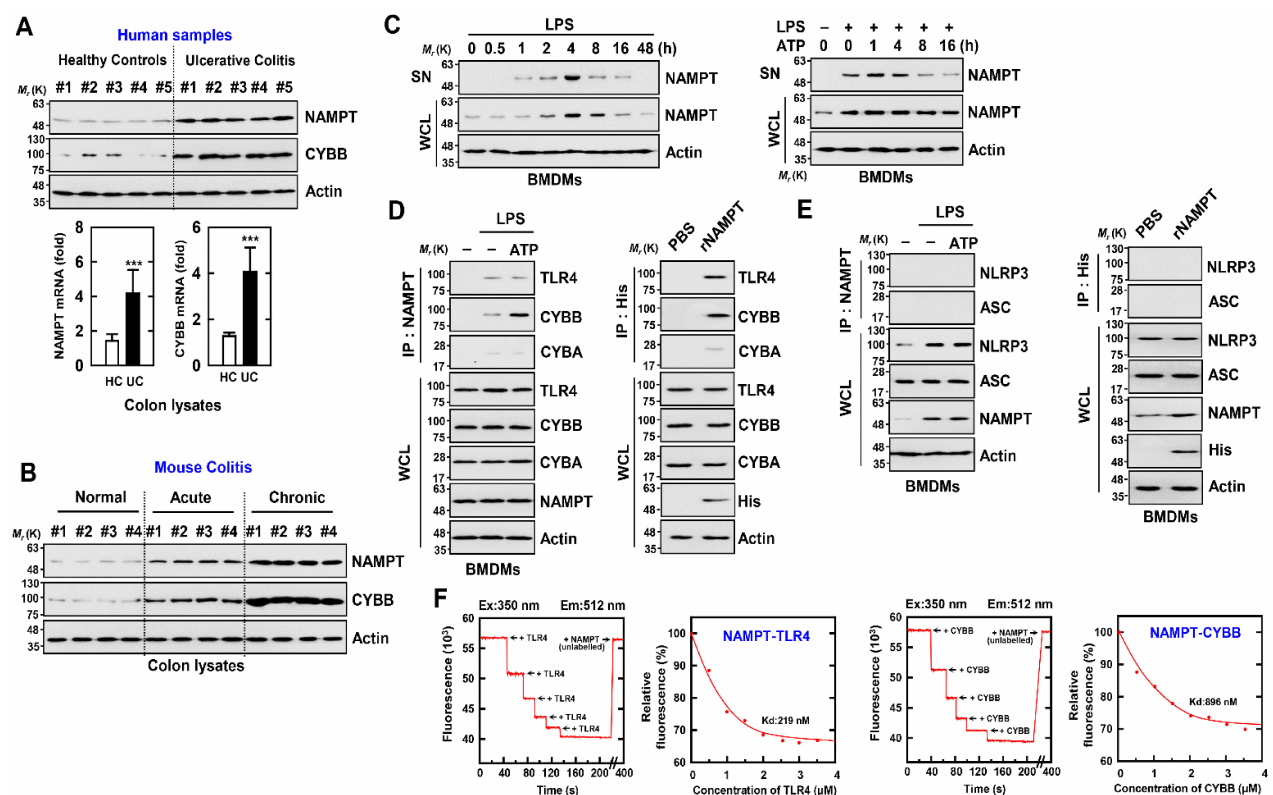
Figure 2. eNAMPT directly binds with CYBB or TLR4 ( A ) Normal human cases alongside UC patients were employed for IB with α NAMPT and α CYBB. WCLs (whole cell lysates) were utilized for IB with α Actin (upper). Representative gel images derived from five independent healthy controls and patients are shown. NAMPT mRNA and CYBB mRNA expression measured by quantitative real-time PCR (lower). Five of ten normal human and UC patients’ data are shown. Statistical significance was evaluated by the Student’s t -test coupled with the Bonferroni adjustment (*** p < 0.001) versus human normal. ( B ) Colon of normal, acute and chronic colitis mouse were analyzed for IB with α NAMPT and α CYBB. WCLs were used for IB with α Actin. Biological replicates ( n = 10) for each condition were performed. ( C ) BMDMs were activated with LPS (100 ng/mL) for the durations indicated (left), then primed with LPS (100 ng/mL) for 4 h before being stimulated with ATP (1 mM) for the times indicated (right). IB in supernatant (SN) with α NAMPT and WCL with α NAMPT or α Actin. ( D , E ) BMDMs were primed with LPS and stimulated with ATP (left) or incubated with rNAMPT (1 µ g/mL) for 2 h (right). BMDMs were treated with IP with α NAMPT or α His, trailed by IB with α TLR4, α CYBB or α CYBA ( D ) and IB with α ASC or α NLRP3 ( E ). WCLs were used for IB with α TLR4, α CYBB, α CYBA, α ASC, α NLRP3 or α Actin. ( F ) Titration of fluorescently labeled TLR4 or CYBB with unlabeled NAMPT, using curve fit analysis to determine Kd (219 and 896 nM). The data come from five independent experiments that yielded comparable